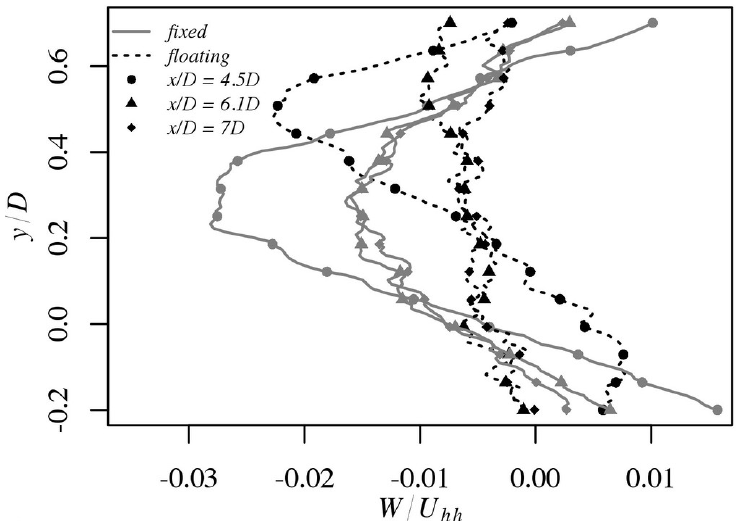
Figure 11. Far wake profiles of W/U distances 4.5 D , 6.1 D and 7 D